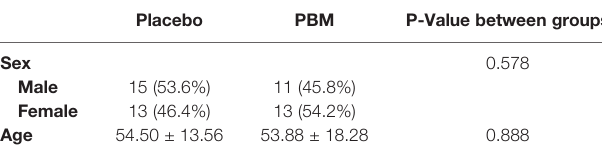
TABLE 1 | Sex and age distribution between the two